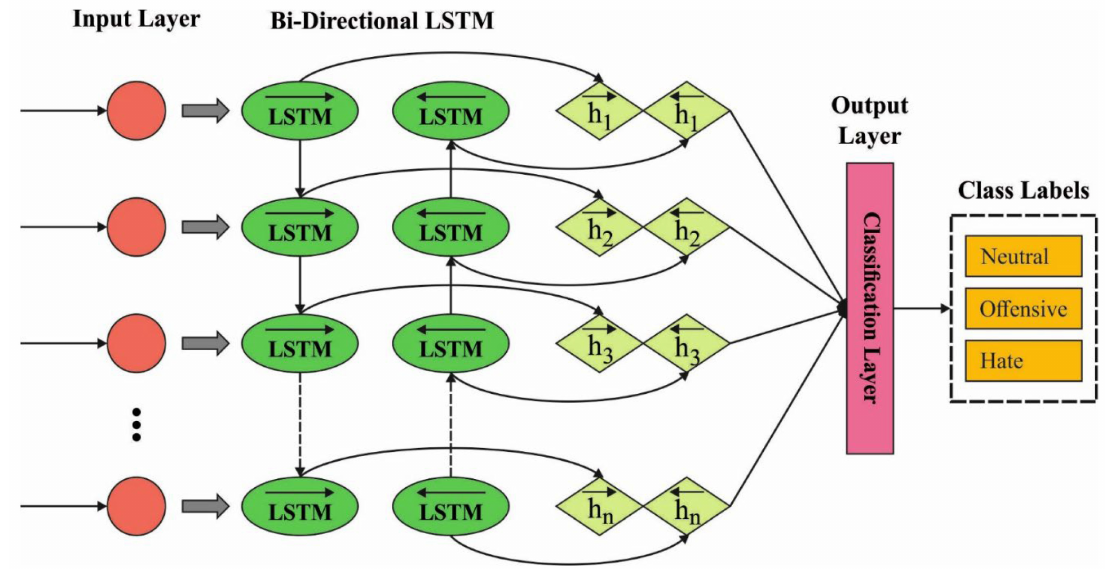
Figure 2. Structure of